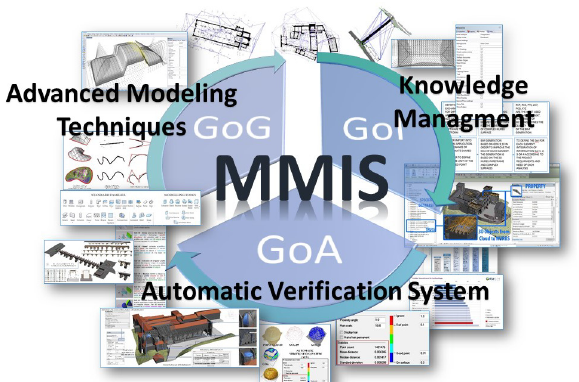
Fig. 2. BIM viewed as a Modelling&Management Information System (MMIS) based on the integration of Grades of Generation (GoG), Grades of Information (GoI) and Grade of Accuracy (GoA). MMIs defined ADT, KM and AVS for each case